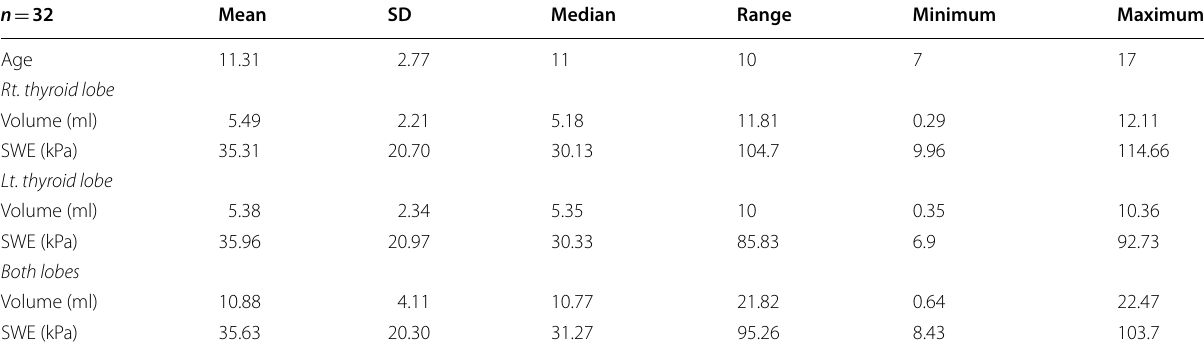
Table 2 Descriptive analysis of age, volume and elasticity in AIT